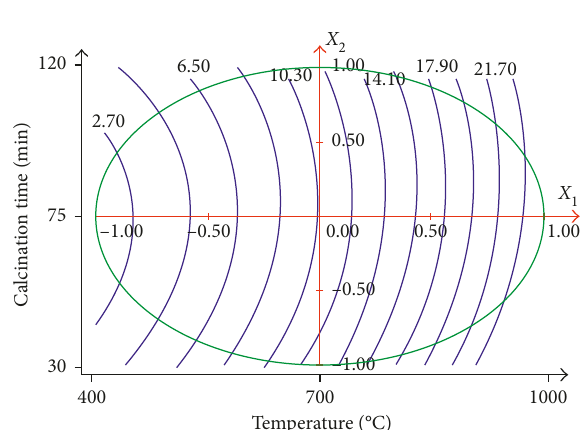
Figure 1: Variation of yield ( Y temperature and time.